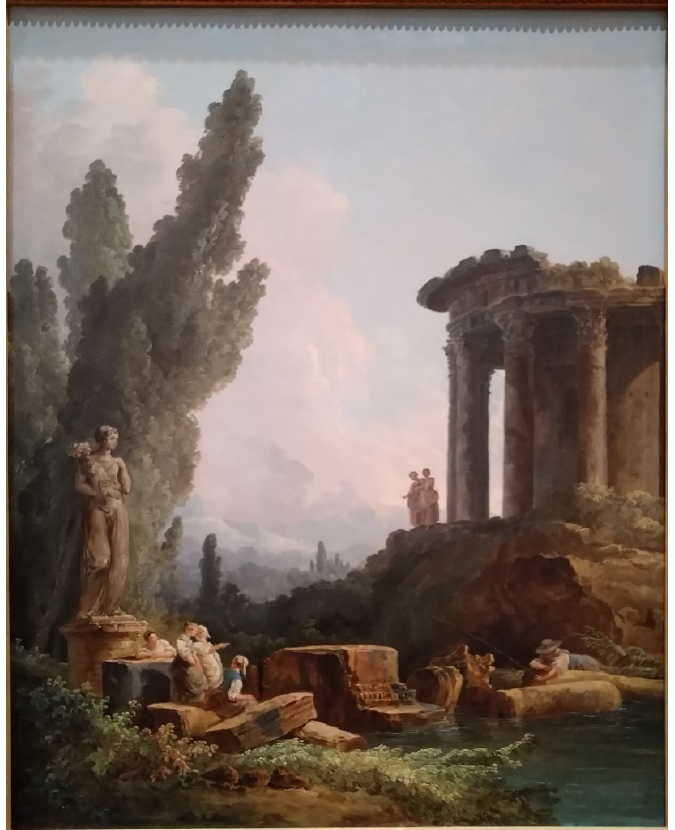
Figure 30. Hubert Robert. Ruines antiques , 1779. Musée des Beaux-Arts de Lyon, dépôt du Musée du